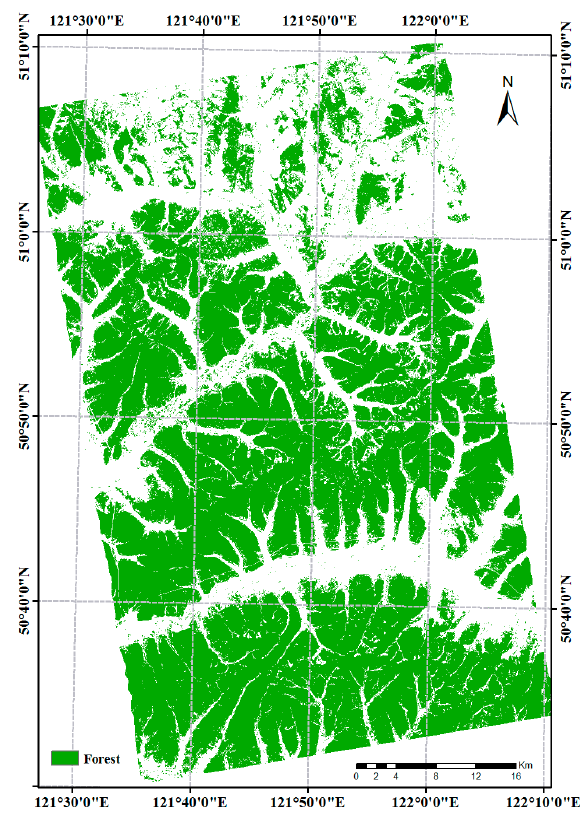
Figure 13. The forest cover map.